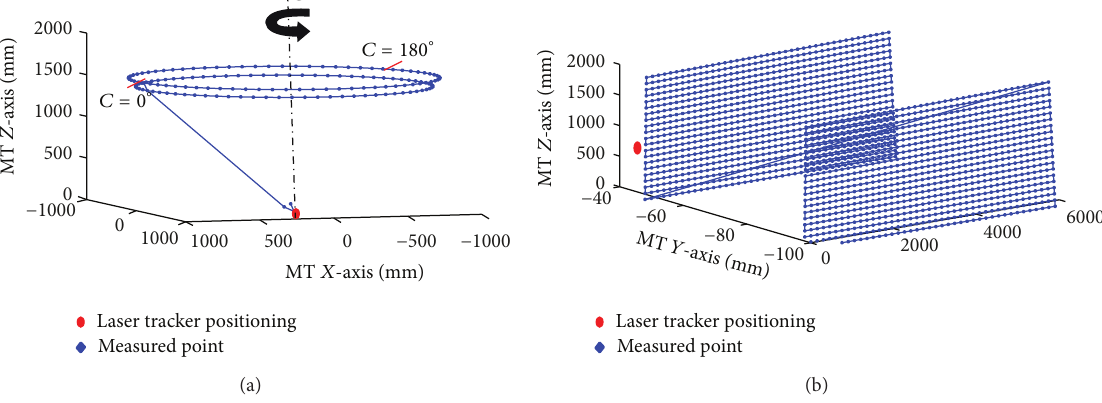
Figure 12: Volume discretization to an independent analysis of the errors.